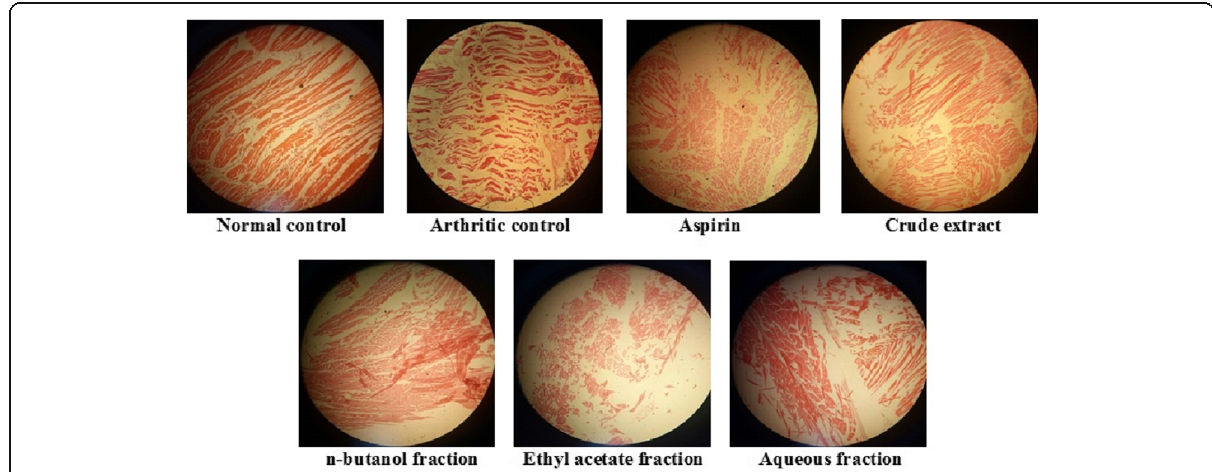
Fig. 6 Histopathological analysis of ankle joint in Sprague Dawley rats at 15th day of treatment after CFA